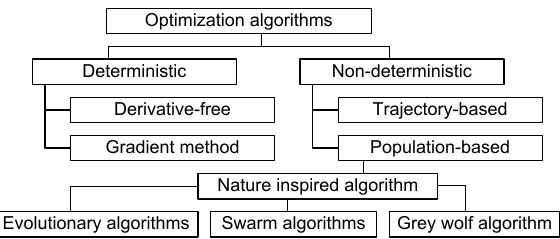
Fig. 1. Classification of optimization